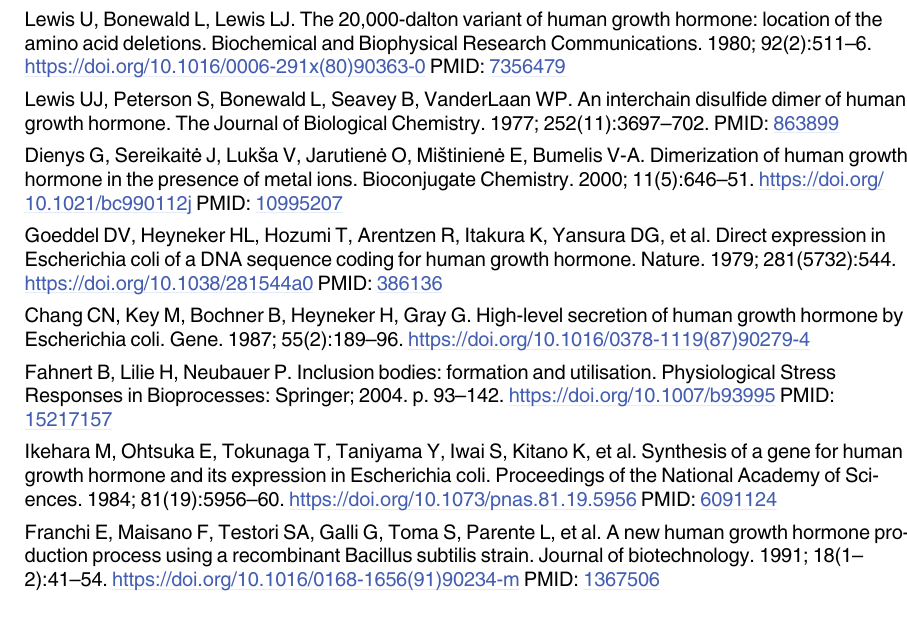
(B) Quantification of rhGH protein expression by ELISA assay during lactation period.